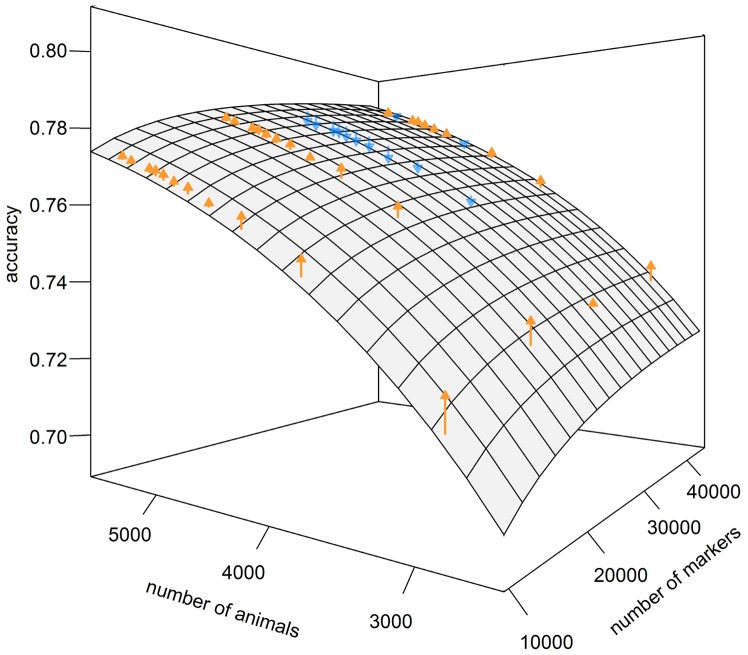
Predicted and empirical values of  (grid) for different #SNPs and different #animals for Holstein-Friesian.Predicted values of  (grid) for different numbers of markers and different number of animals in the training set when using the modified equation of Daetwyler et al. (2010) (D2), an  of 1′151.55 and a weighting factor of . Empirical results obtained with cross-validation experiments with Holstein-Friesian data are symbolized by arrows. Orange arrows represent values that were higher than predicted while blue arrows indicate that empirical values were lower than the predicted ones.